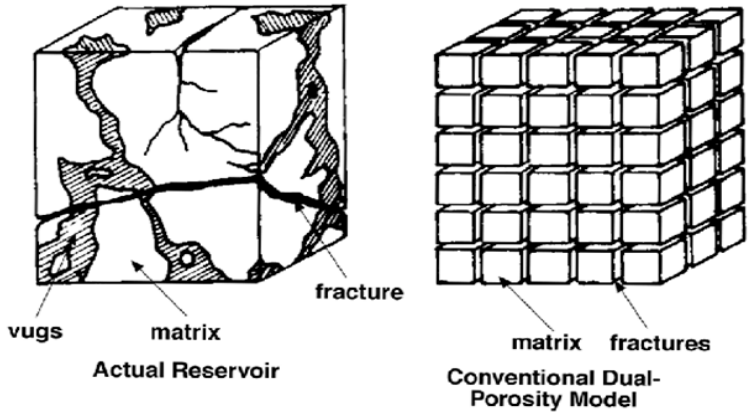
Figure 4. Idealization of a fractured reservoir [13].